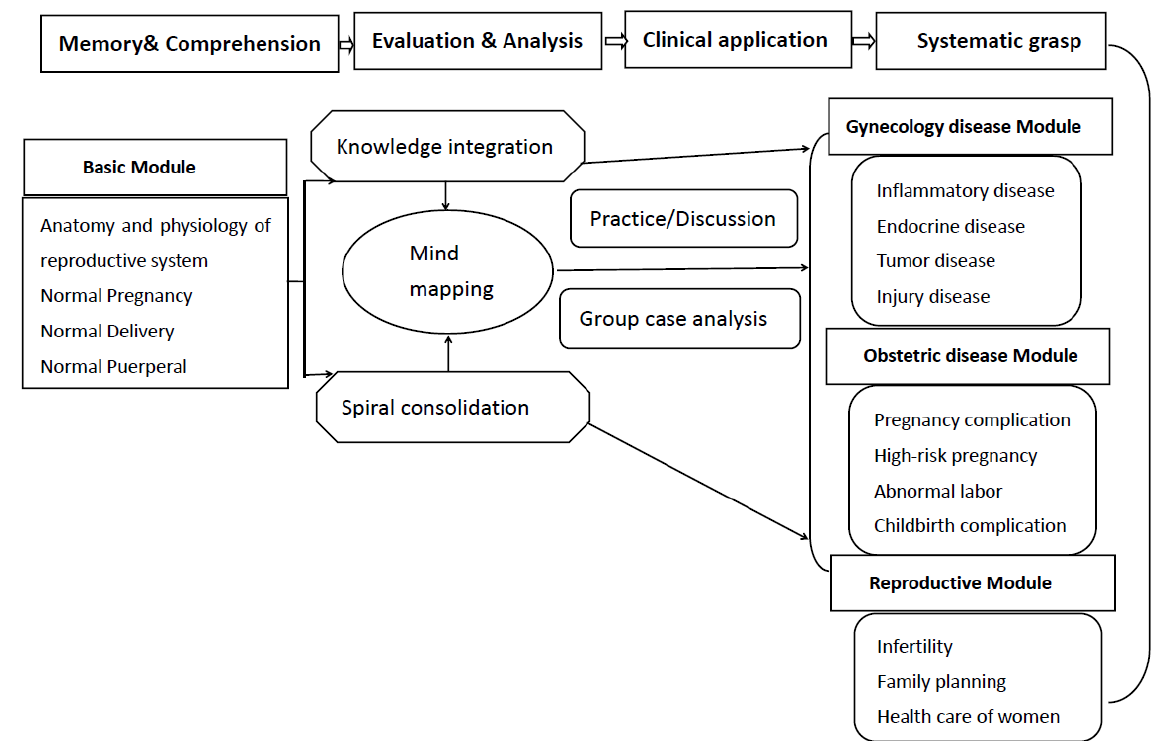
Figure 1. Divided modules of the course.